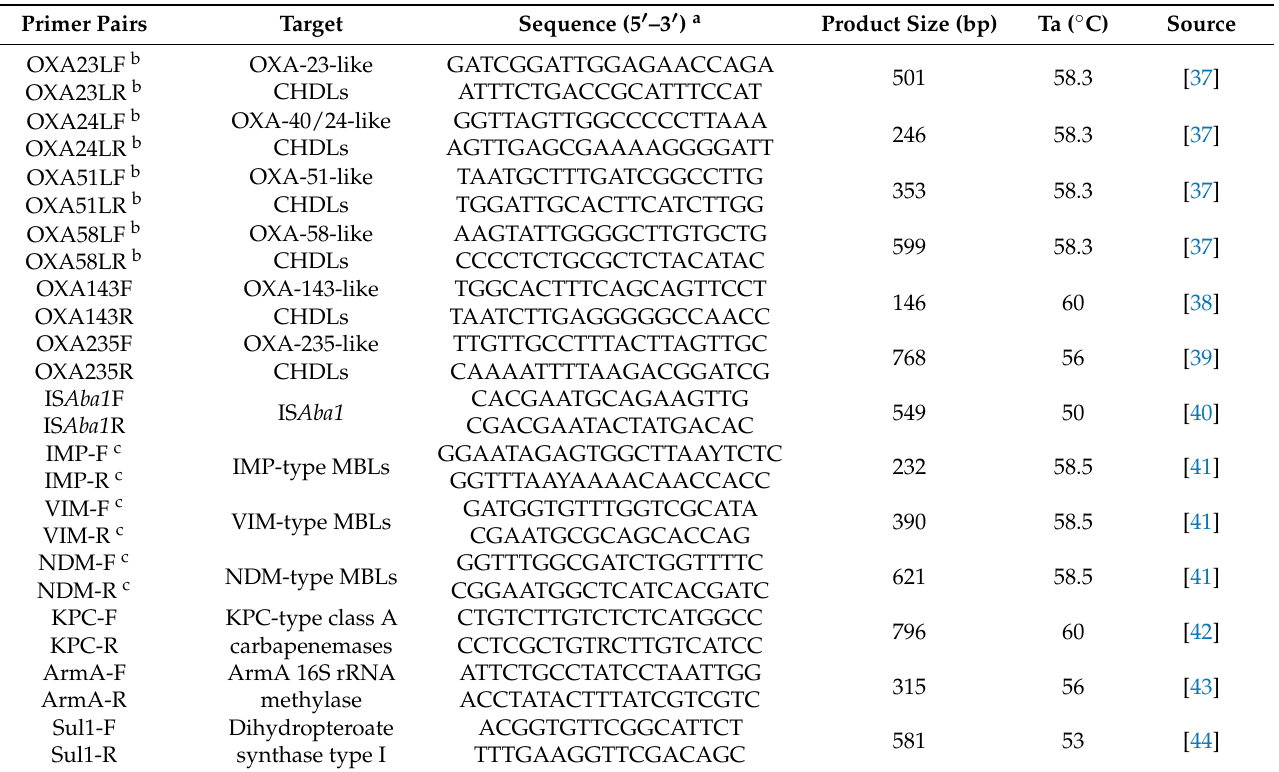
Table 1. Oligonucleotides used as primers for PCR amplification of antimicrobial resistance genes in A. baumannii